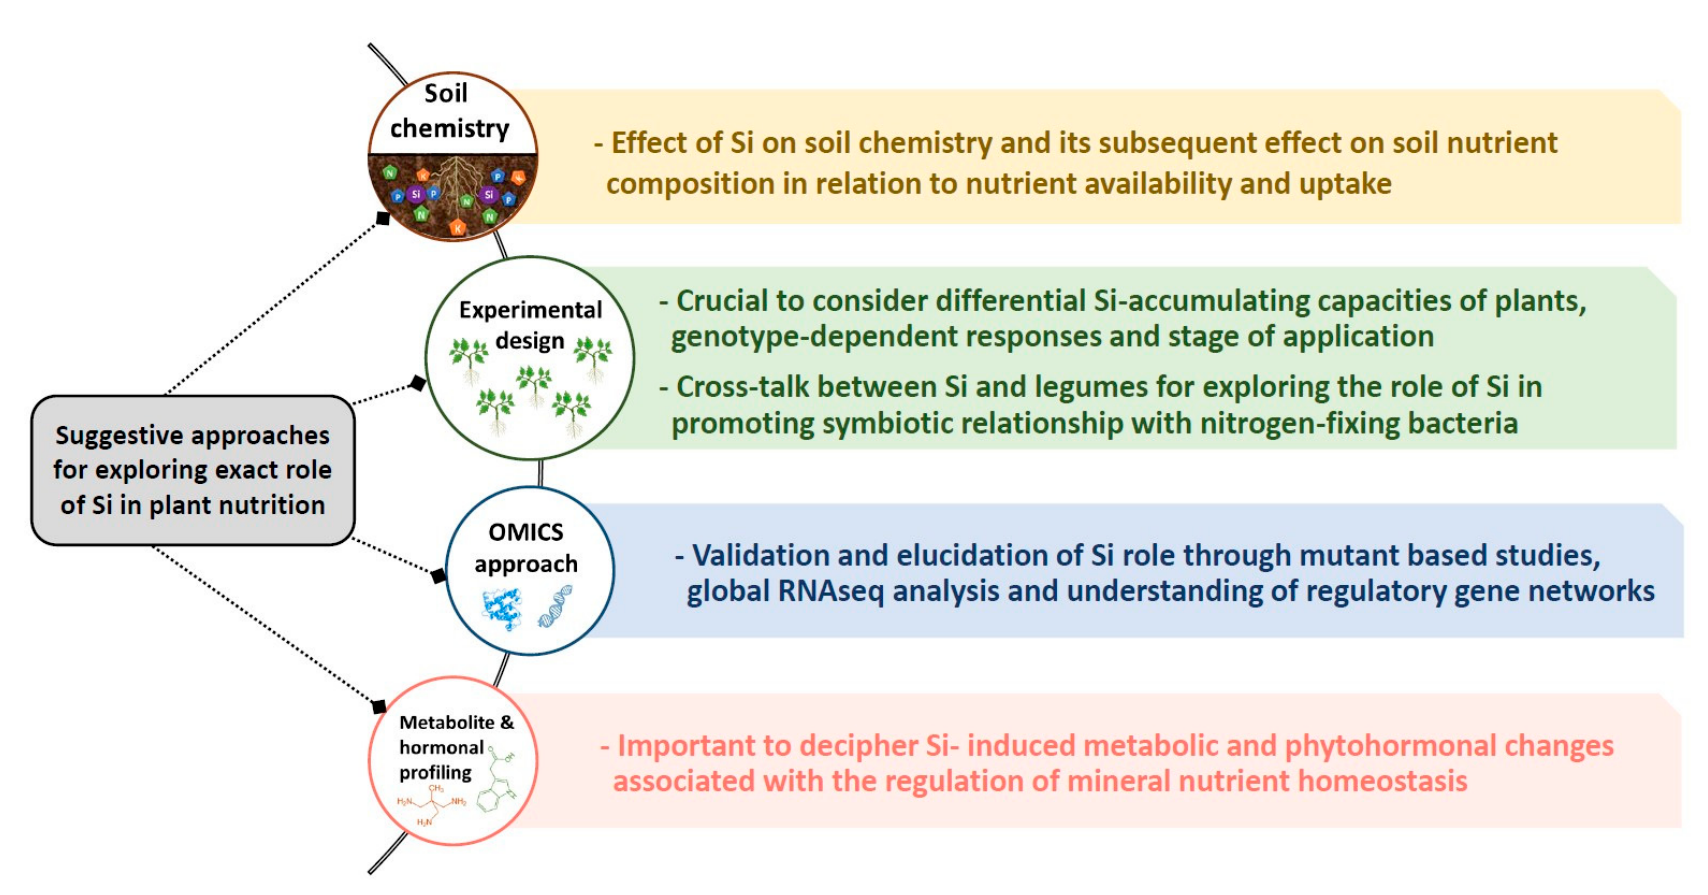
Figure 3. Proposed approaches for discovering the gap of knowledge in Si nutrition and its interaction with nutritional stresses.